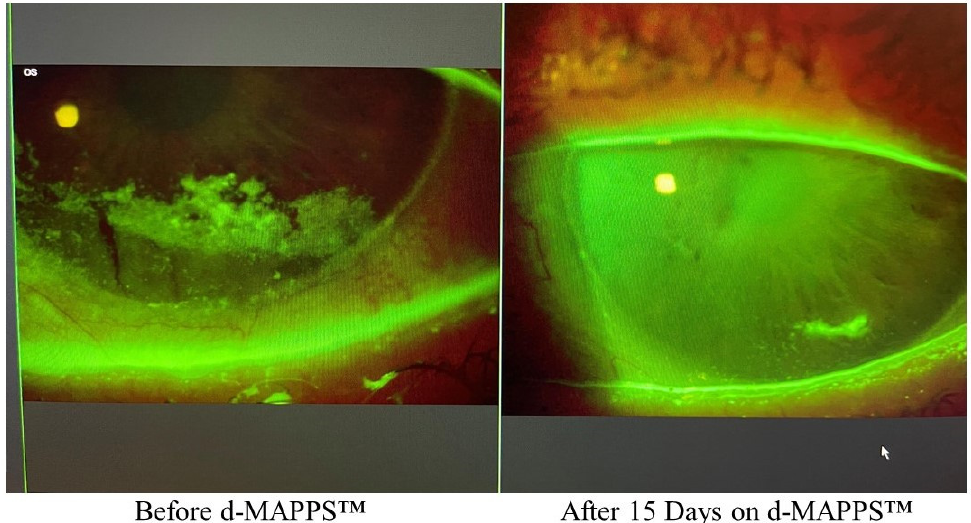
Figure 2. Therapeutic potential of d-MAPPS™ in the treatment of neurotrophic keratitis. Significant improvements in neurotrophic keratitis were observed in an 80-year-old patient who received d-MAPPS™ for 15 days (3–4 times per day for 4 days, then 2–3 times a day).